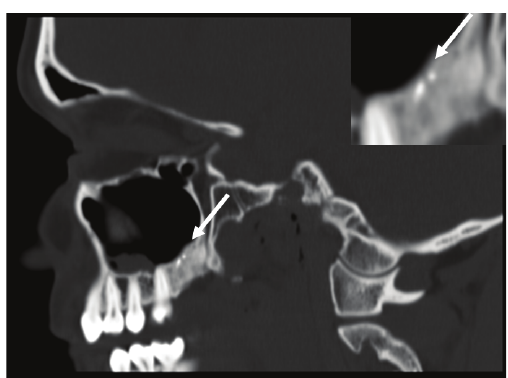
Figure 4. Sagittal section of non-contrasted CT scan shows two retained remnants of gutta-percha (white arrow) in the left maxilla in the location of previous dental extractions. Inset in the top-right corner reveals a zoomed image of the two gutta-percha